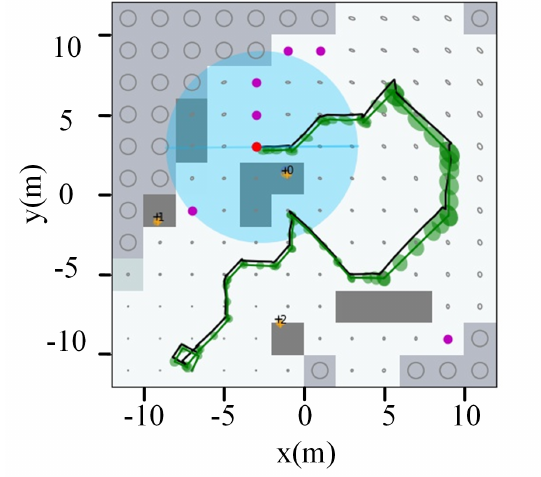
Figure 6. An example of our simulation environment, in which the exploration range is 20 m × 20 m, the light blue circular area the robot detection range, the light gray grid the unknown area, the gray grid the obstacle grid, the ellipse in the grid the virtual landmark uncertainty, the black plus the actual position of the landmark in the map, the yellow plus the estimated landmark position by the robot, the black trajectory the robot’s actual trajectory, the green trajectory the robot’s estimated trajectory, the green ellipse the robot’s pose uncertainty, the purple point the candidate frontier waypoints (action space), and the red point the selected frontier waypoint (action).